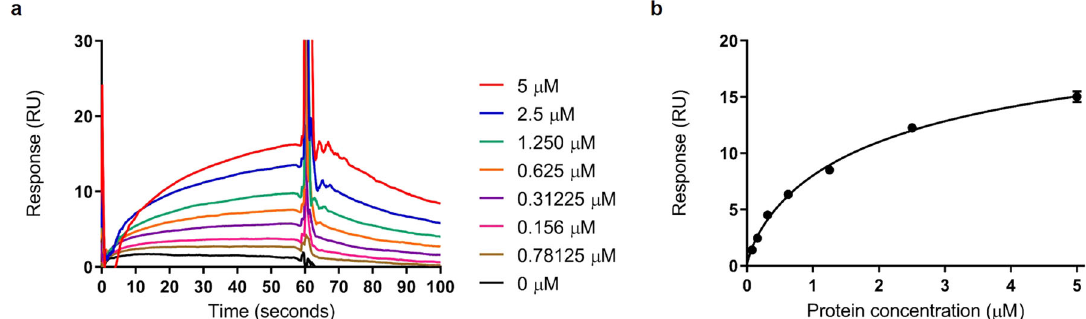
Fig. 7 ToxR is a c-di-GMP-binding protein. Puri fi ed ToxR was tested for dinucleotide binding by Surface Plasmon Resonance (SPR) as previously described 67 . a SPR sensorgrams showing af fi nity measurements of an increasing range of ToxR concentrations (0 – 5 µM) binding to biotinylated c-di-GMP. Protein binding and dissociation phases are shown. b Af fi nity fi t for ToxR-c-di-GMP binding. The binding response for each concentration was recorded, and the K D values for ToxR binding to c-di-GMP (2.36 ± 0,7 µM) were calculated using Biacore T200 BiaEvaluation software version 1.0 (GE Healthcare) and con fi rmed by GraphPad Prism. The experiment was repeated three times